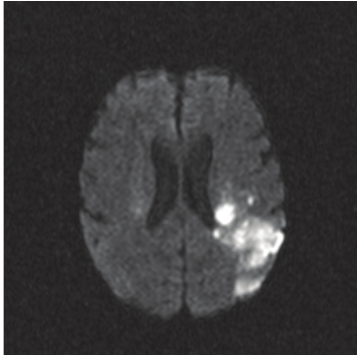
Figure 2: Di ff usion weighted MRI after thrombolysis showing left parietal hyperintensities. Areas of focal intensities were also identified in other location including the right cerebral hemisphere, consistent with embolic source as a likely cause of these bilateral and sporadic hyperintense